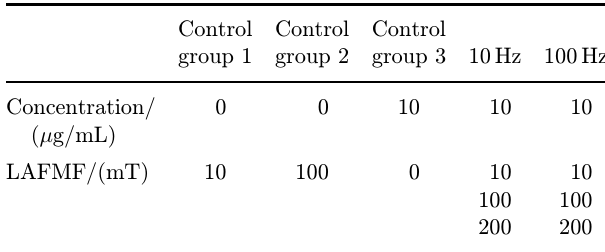
Table 1. Experiment